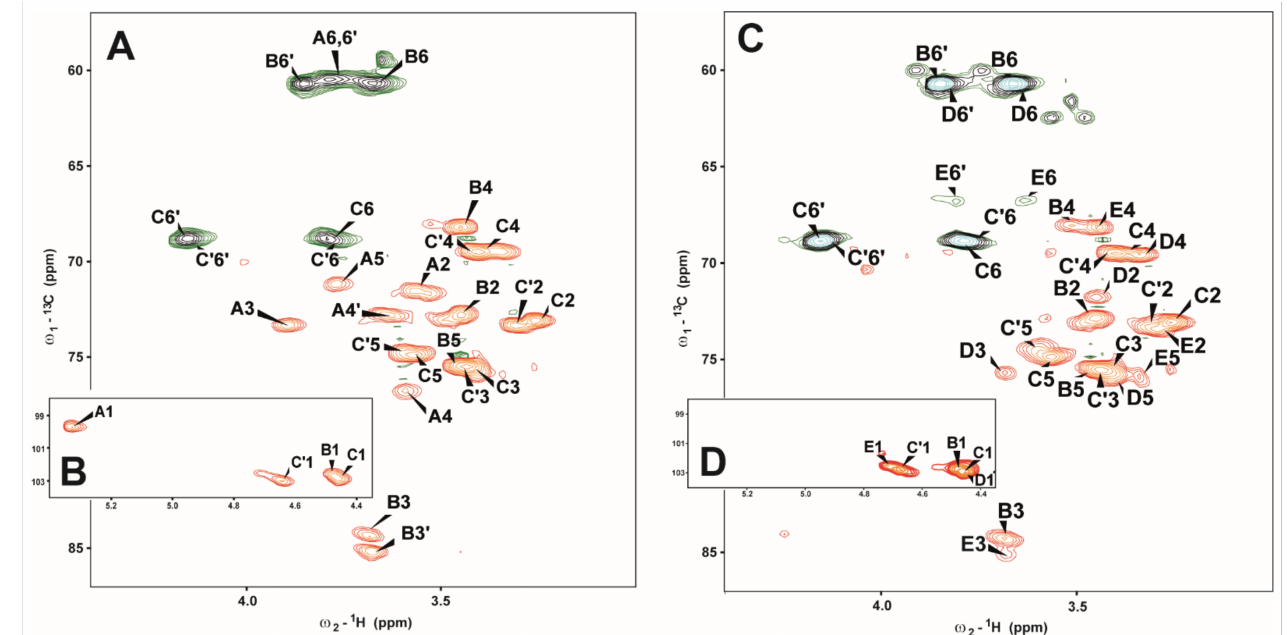
Figure 1. Selected parts of the 1 H- 13 C HSQC-DEPT NMR spectra of fraction II ( A , B ) and fraction III ( C , D ). Table 1. 1 H and 13 C NMR chemical shifts of fraction II separated from Se-Le-30 crude extract. Chemical Shifts (ppm) Sugar Residue